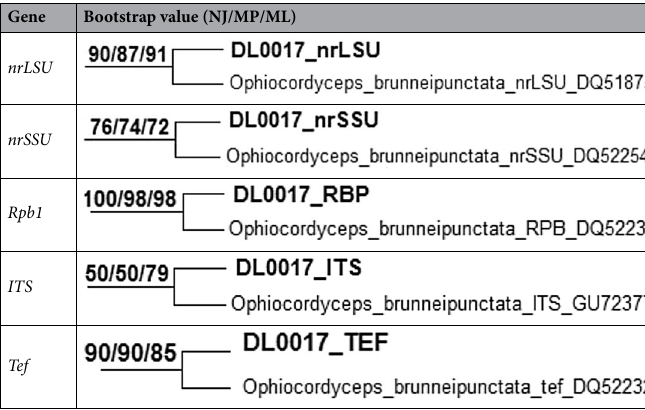
Table 3. DL0017 clustered together with Ophiocordyceps brunneipunctata with bootstrap support.